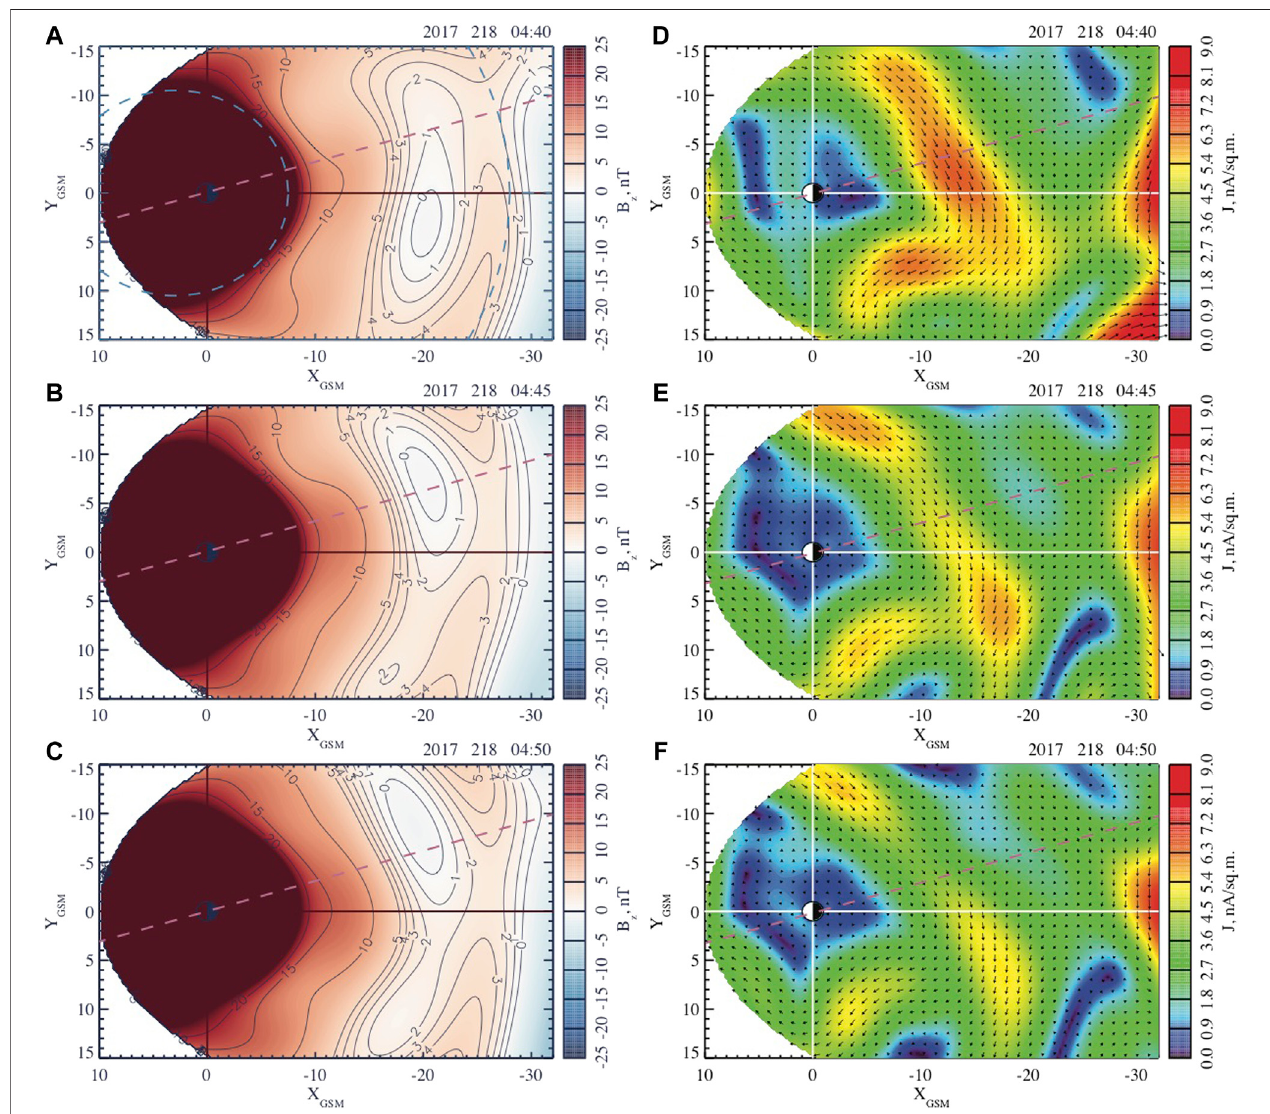
FIGURE7| Distributionsoftheequatorialmagnetic fi eld B z [ (A – C) ]andtheelectriccurrent[ (D – F) ]obtainedusing0-degreetiltanglefortheseconddipolarizationof the 6 August 2017 substorm. The format is similar to Figure 6 . The oblique dashed pink lines show the meridional planes, which are used below to investigate this dipolarization. The dashed blue arcs in panel (A) show sample integration paths, which are used below to evaluate the closed magnetic fl ux evolution.